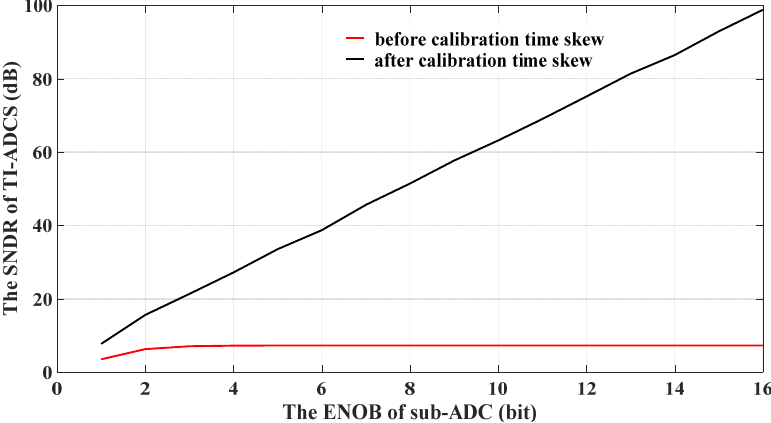
Figure 12. The performance of the proposed technique with different ENOB of the sub ‐ ADC. The minimum value of ∑(cid:4666)𝑒 (cid:3036) (cid:4670)𝑛(cid:4671)(cid:4667) (cid:2870) is obtained by the least square method. Hence, the cumulative error ∑(cid:4666)𝑒 (cid:3036) (cid:4670)𝑛(cid:4671)(cid:4667) (cid:2870) is affected by quantization error and white Gaussian noise. In